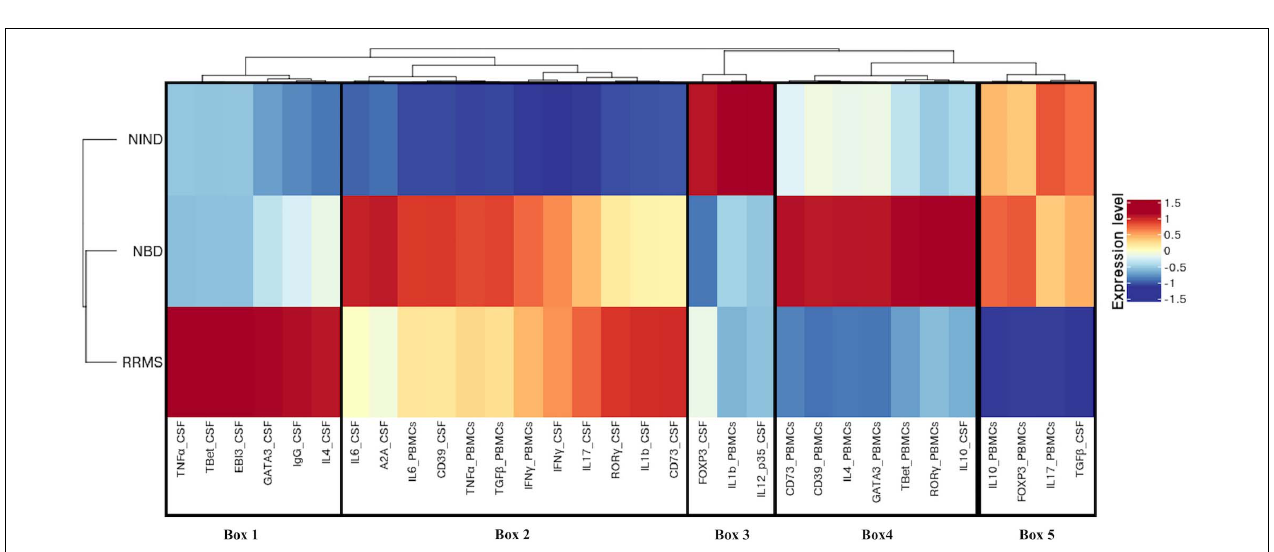
FIGURE 3 | (A) Principal component analysis (PCA) performed on the full set of CSF and blood measured parameters significantly segregated the NIND, NBD, and RRMS groups. The samples are represented by dots. Each color represents a group of patients. (B) The vectors represent the 15 most influencing variables for each of the principal components PC1 and PC2. The longer the arrow is, the more it influences the variance. The ellipses indicate 95% confidence.